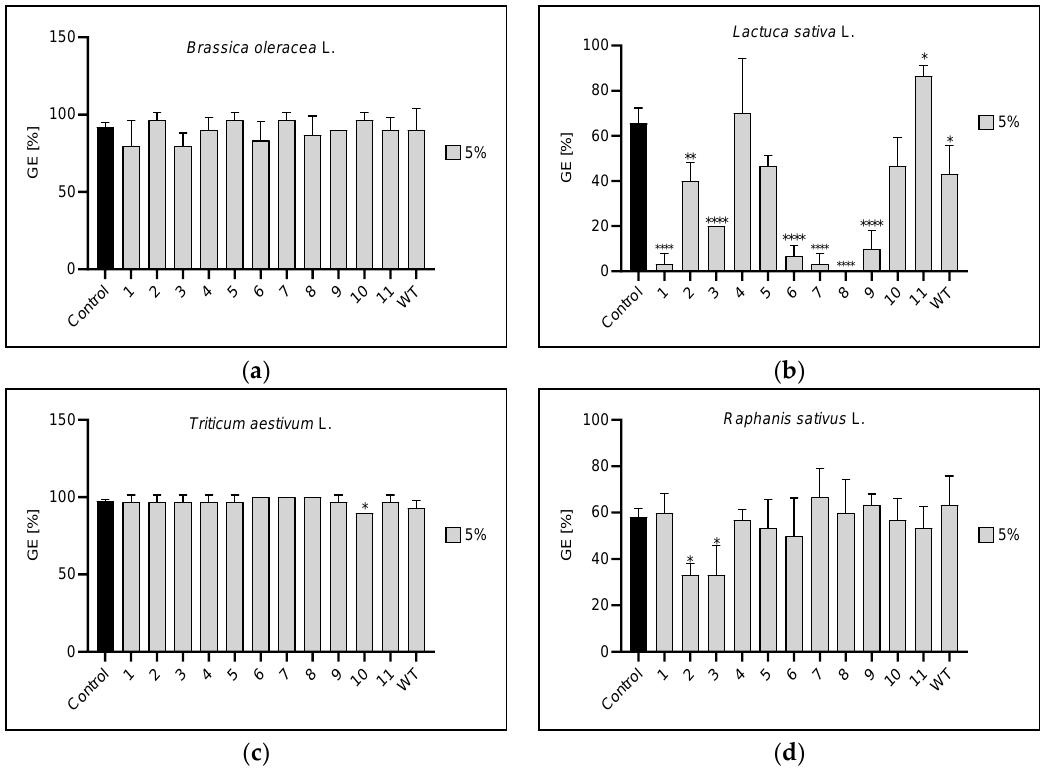
Figure 3. Percentage of germination of broccoli ( a ), lettuce ( b ), wheat ( c ), and radish ( d ) seeds treated with 5% concentration for all algae clones tested (1-11, WT) and control (Control). Values represent mean ± SD, n = 10 plants, * p < 0.1, ** p < 0.01, **** p < 0.0001 compared to control (ANOVA and Dunnett’s a posteriori test).